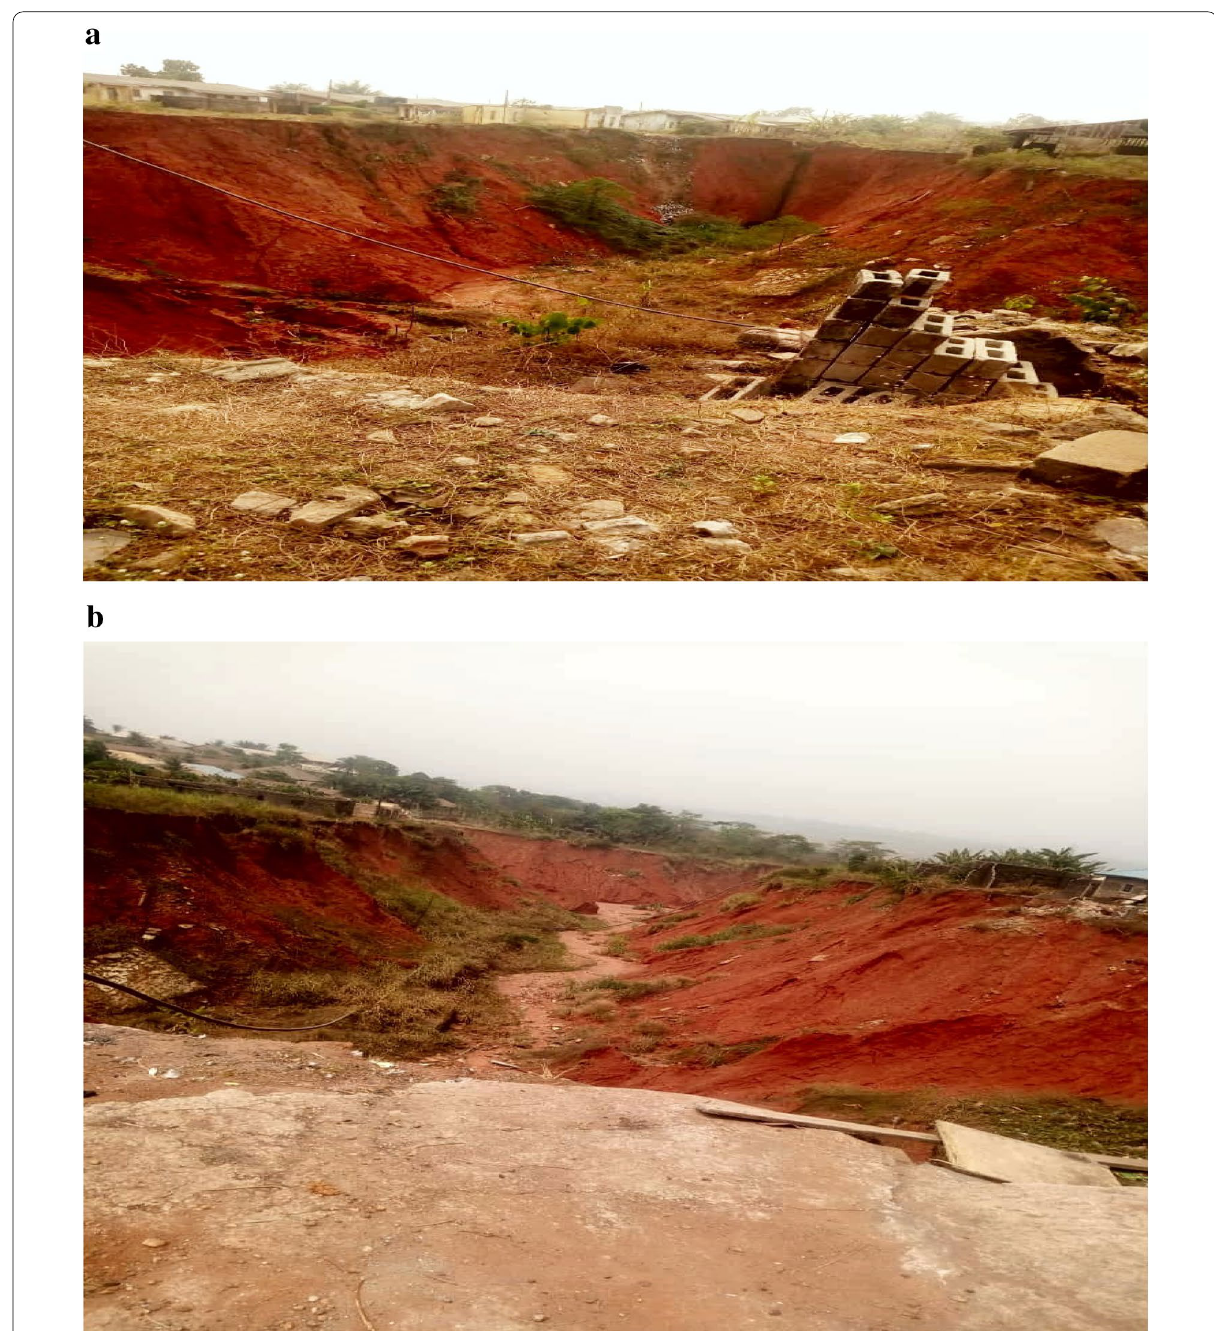
Fig. 9 a Landslide on Iguosa area threatening lives and properties in the study area. b The road leading to various homes in the study area have be truncated by erosional activities (photo by